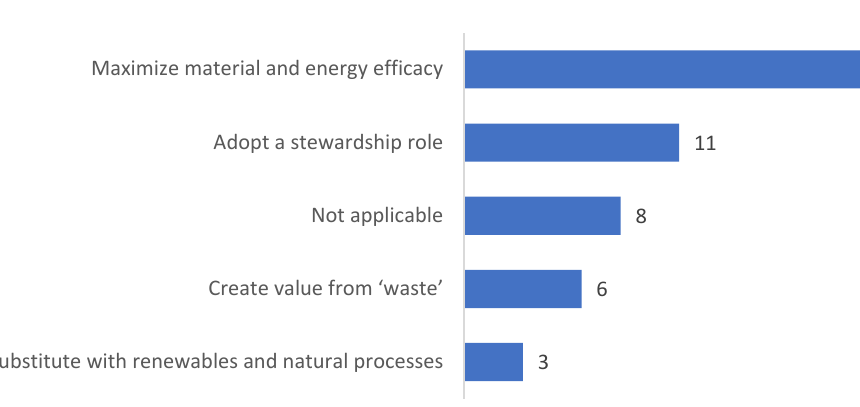
Figure 3. Projects by SBM archetypes. Source: own study.